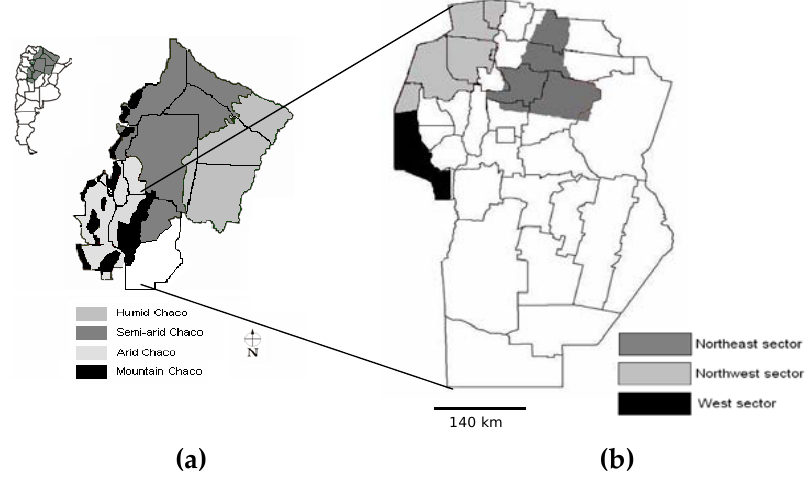
Figure 1. ( a ) Location of the Gran Chaco and Cordoba Province in Argentina, and different eco-regions within the Gran Chaco; and, ( b ) Study area in the Cordoba Province; different grey tones indicate the three sectors used to stratify the sampling.